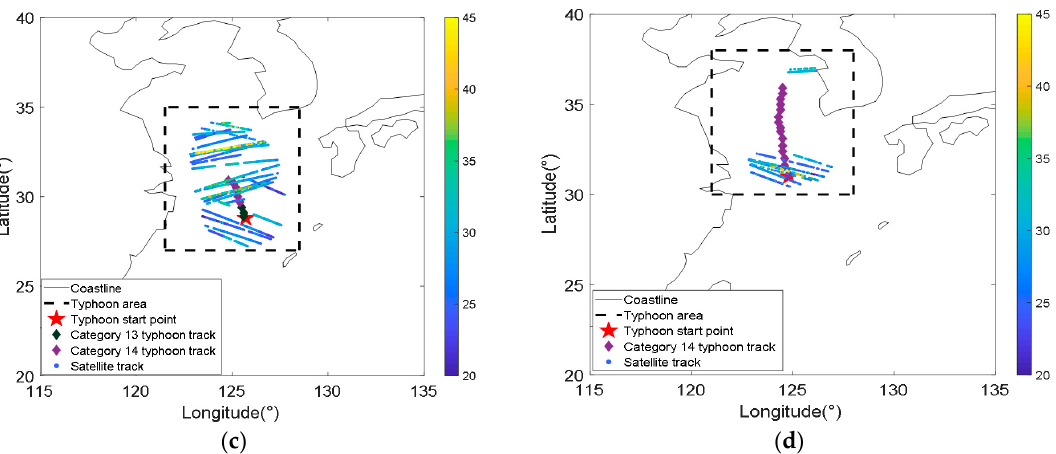
Figure 7. ( a ) 2020.8.23 CYGNSS satellite flight track and corresponding CNN wind speed; ( b ) 2020.8.24 CYGNSS satellite flight track and corresponding CNN wind speed; ( c ) 2020.8.25 CYGNSS satellite flight track and corresponding CNN wind speed; ( d ) 2020.8.25 CYGNSS satellite flight track and corresponding CNN wind speed. The color bar on the right represents the wind speed value, Unit: m/s.